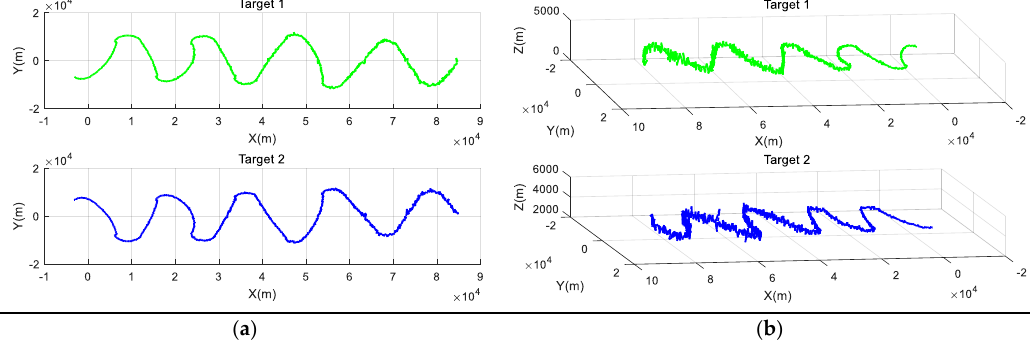
Figure 3. The corresponding tracks of two maneuvering targets. ( a ) The corresponding tracks in two dimensions; ( b ) The corresponding tracks in three dimensions.